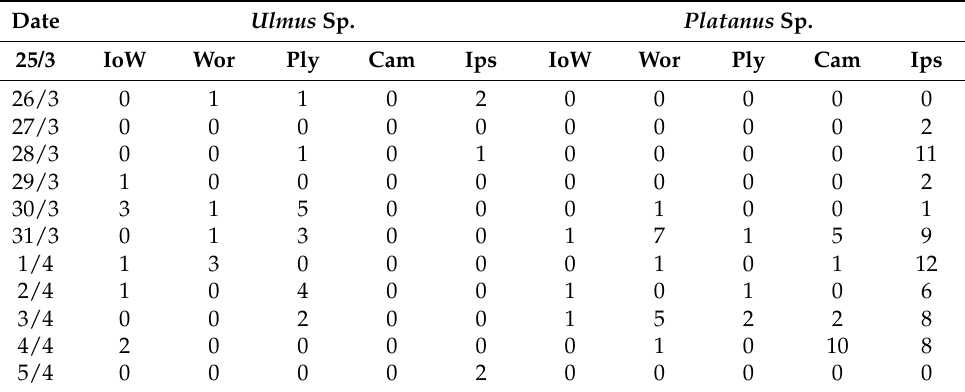
(Ply), Cambridge (Cam) and Ipswich (Ips) for Ulmus (elm) and Platanus (plane). Table 2. Observed pollen concentrations in 2014 at the Isle of Wight (IoW), Worcester (Wor), Plym ‐ Date Ulmus Sp. Platanus Date Ulmus Sp. Platanus Sp.